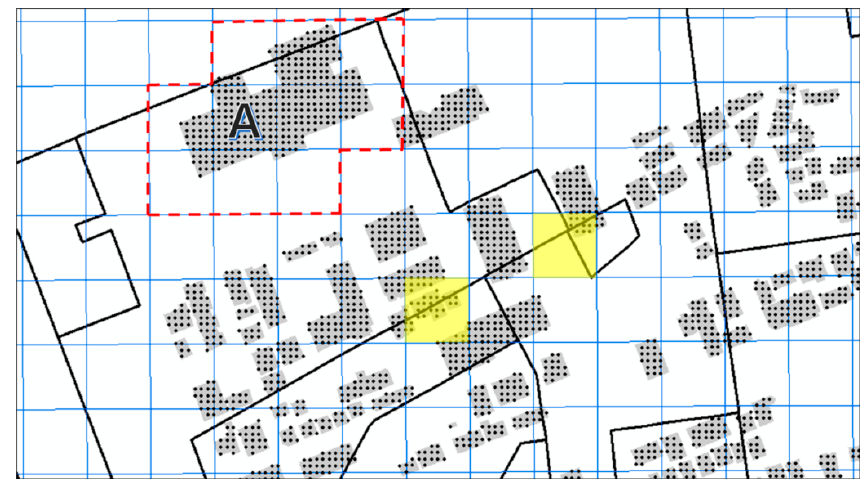
Figure 5. Standardization method using building floor area data.